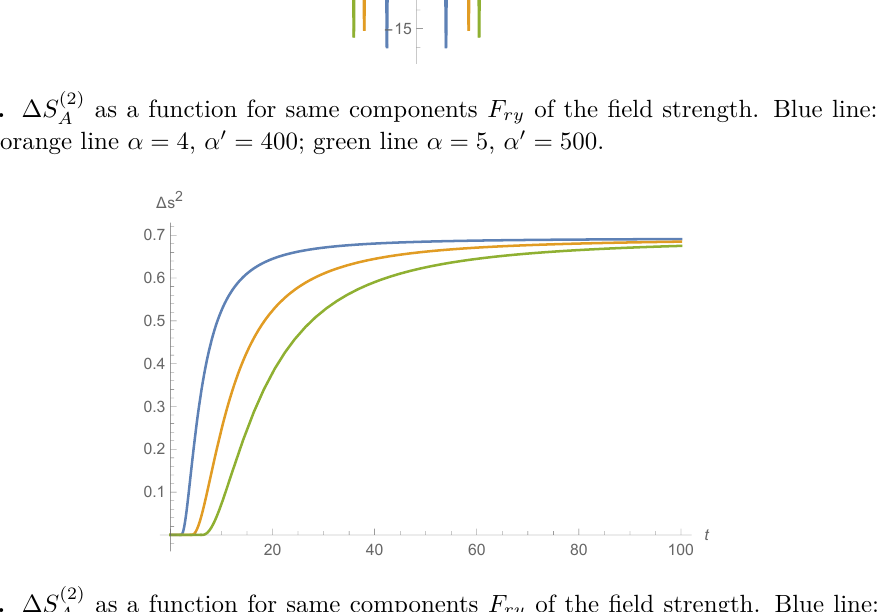
Figure 9. ∆ S (2) as a function for same components F ry of the field strength. Blue line: x = 2 ; A orange line x = 4 ; green line x = 6 . We keep (cid:15) = 0 . 01 in all